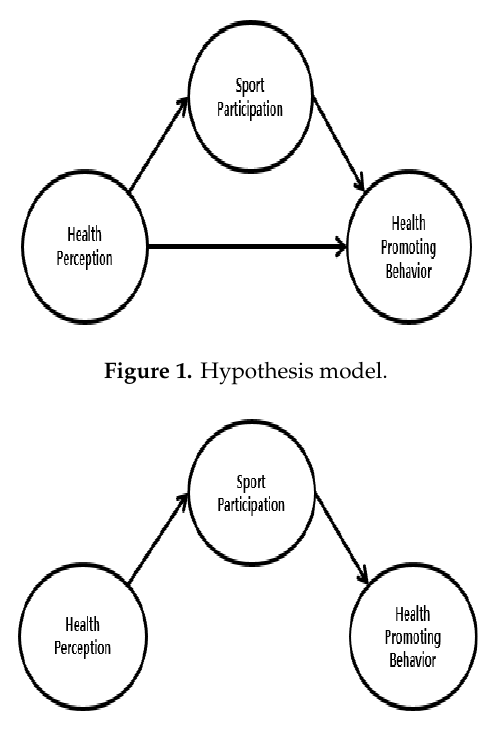
Figure 2. Competition model.